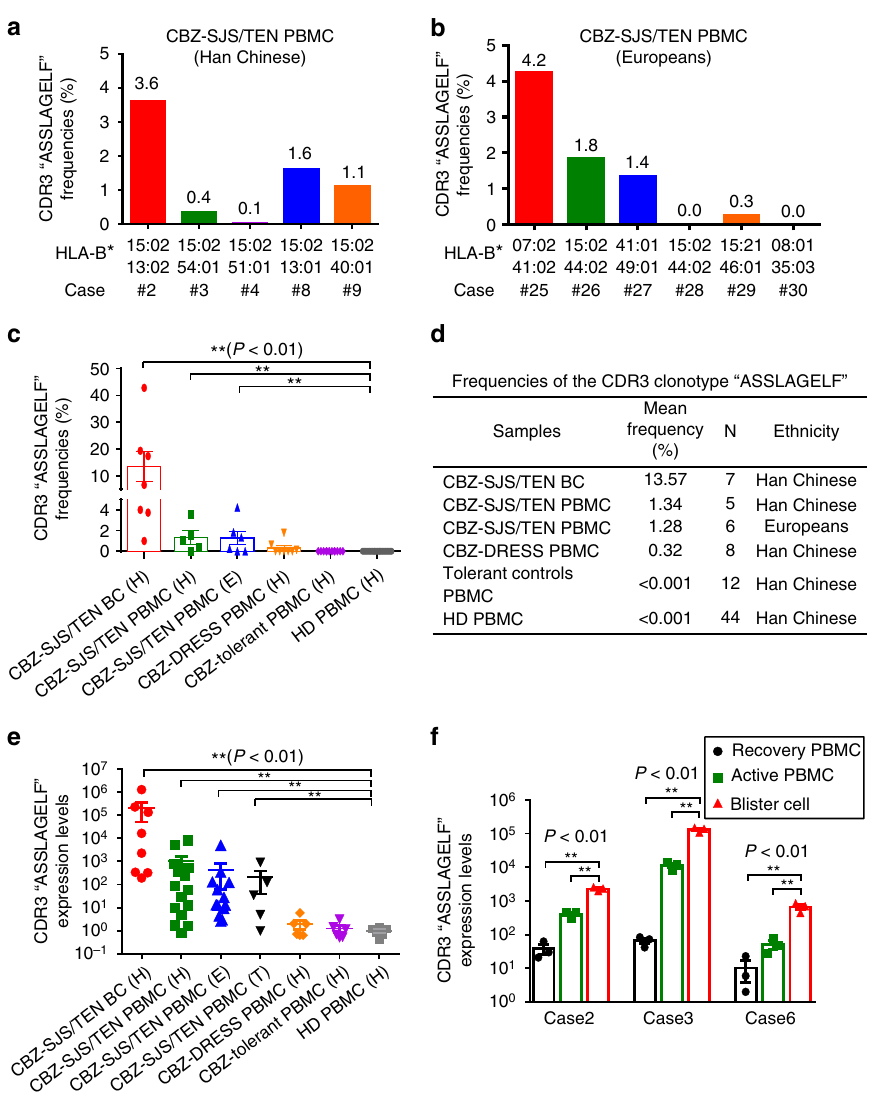
Fig. 3 Expression of the public TCR β CDR3 clonotype in the CBZ-SCAR patients . a , b The frequencies of the speci fi c CDR3 “ ASSLAGELF ” were determined by TCR NGS using the PBMC of patients of Han Chinese ( n = 5) and Europeans ( n = 6) with CBZ-SJS/TEN. c , d Comparison of the frequencies of the CDR3 “ ASSLAGELF ” in the blister cells (BC) and PBMC of patients with CBZ-SCAR, CBZ-tolerant controls, and healthy donors (HD). The results are expressed as mean ± s.e.m. with each dot representing the data of an individual. Statistical analysis was generated using an unpaired, two-tailed Student ’ s t test. e Determination of the expression levels of the speci fi c CDR3 by quantitative real-time PCR in the samples of BC and PBMC of patients with CBZ- SCAR of different ethnic populations including Han Chinese (H), Thai (T), and Europeans (E). The samples used for analysis include blister cells of CBZ- SJS/TEN (Han Chinese ( n = 8)), PBMC of CBZ-SJS/TEN (Han Chinese ( n = 15); Europeans ( n = 13); Thai people ( n = 5)), PBMC of CBZ-DRESS (Han Chinese ( n = 6)), PBMC of tolerant controls (Han Chinese ( n = 6)), and PBMC of healthy donors (Han Chinese ( n = 6)). The expression level of the speci fi c TCR β clonotype was normalized by that of CD3, and the detection limit of the TCR β clonotype/CD3 ratio was 0.0001. The results are expressed as mean ± s.e.m. with each dot representing the data of an individual. Statistical analysis was performed using an unpaired, two-tailed Student ’ s t test. f Determination of the expression levels of the speci fi c CDR3 by quantitative real-time PCR in the samples of BC and PBMC of patients with CBZ-SCAR in the active or recovery disease states. The results are representative data of three cases and each with triplicate measurements. The data are expressed as mean ± s.e.m. with each dot representing the data of one sample. Statistical analysis was performed using an unpaired, two-tailed Student ’ s t test. ** P <